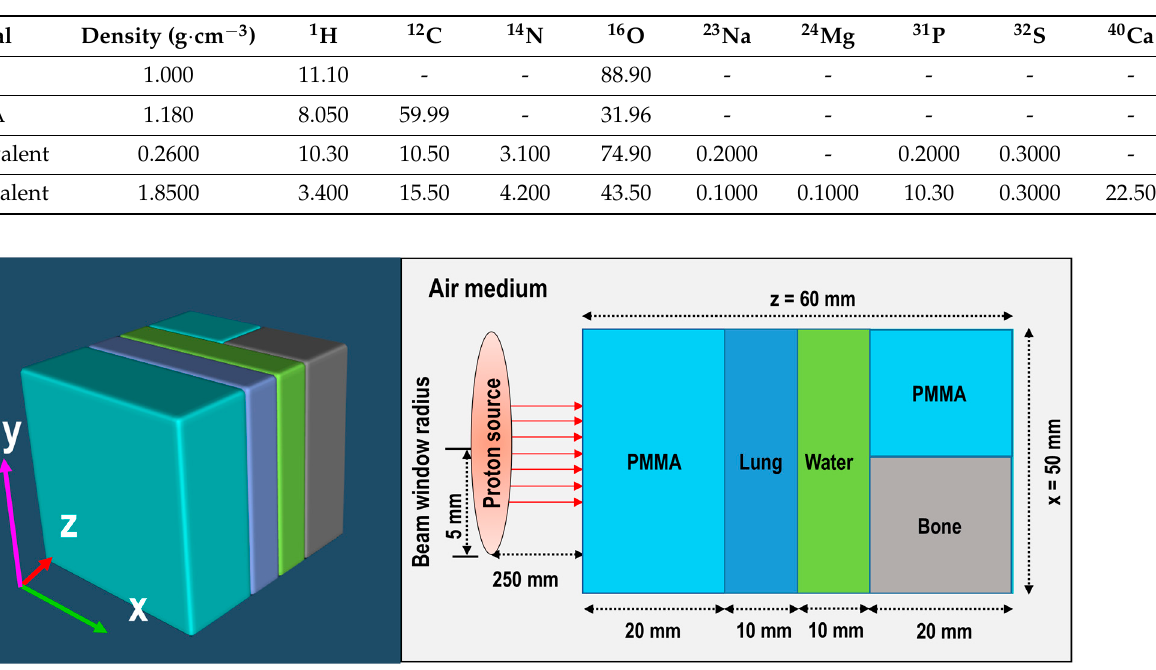
Table 1. Densities and materials composition (shown in weight percent) of the ordinary slab phantom.